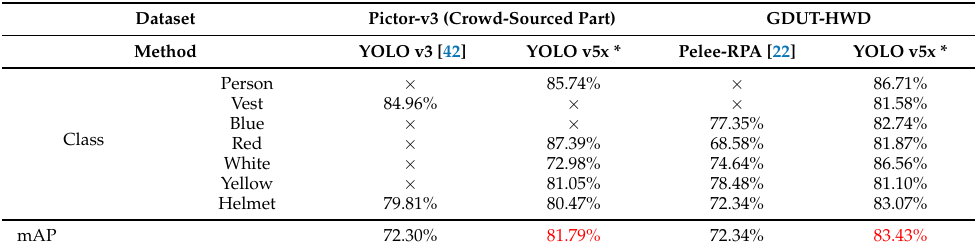
Table 10. Comparison among YOLO v5x and other deep learning methods based on the same